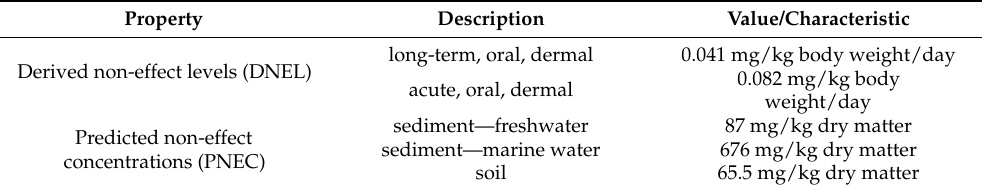
Table 4. Information from safety data sheet of copper powder